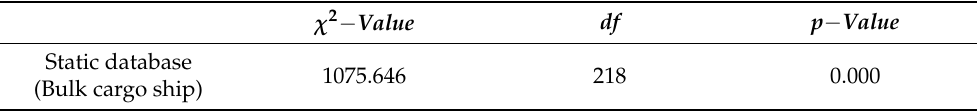
Table 4. Little’s MCAR test for the ship static data was used in the study. The test is based on comparing the observed pattern of missing data to what would be expected if the data were missing completely at random. If the test fails to reject the null hypothesis that the data are missing completely at random, then it can be assumed that the missing data do not depend on any unobserved variables and can be safely ignored in subsequent analyses. The χ 2 − value is a test statistic used to compare the fit between observed and theoretical values. Degrees of freedom ( df ) are used to calculate the number of independent variables in a statistical test. The p − value is the result of a hypothesis test and represents the probability that the data fit the MCAR assumption. If the p − value is less than the significance level (usually 0.05), then the MCAR assumption can be